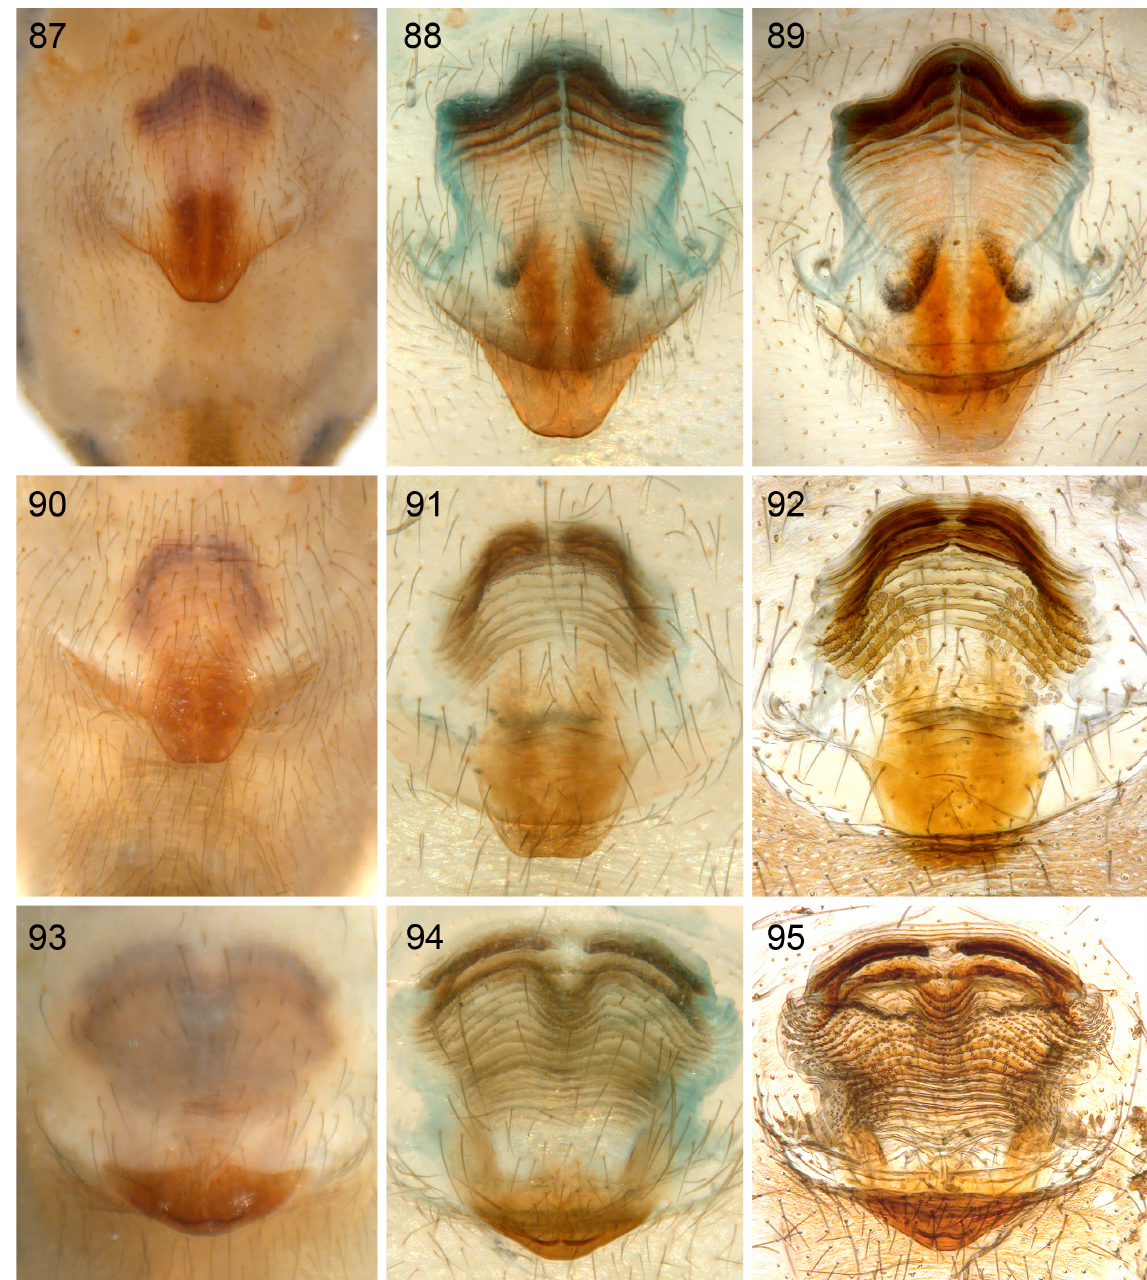
Figs 87–95. Aetana kiukoki group. Female genitalia; untreated in ventral view, cleared in ventral and